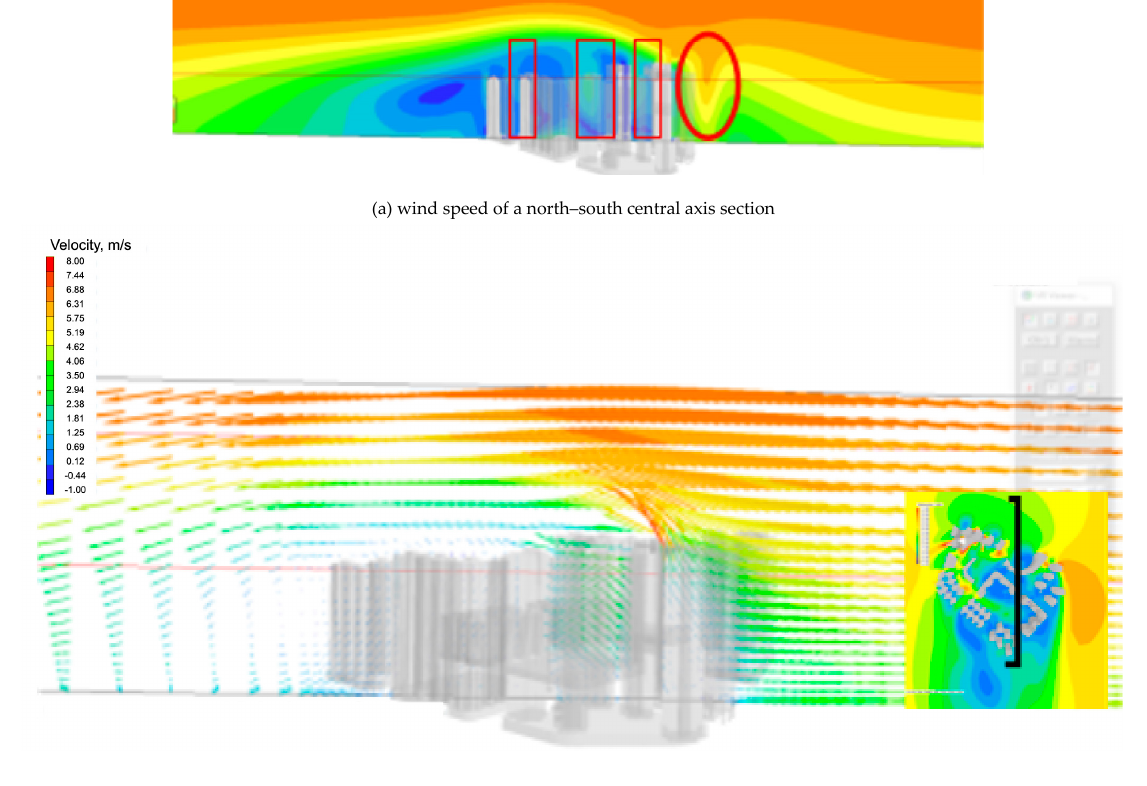
Figure A6. Winter wind speed and streamline vector diagram of a north–south central axis section.